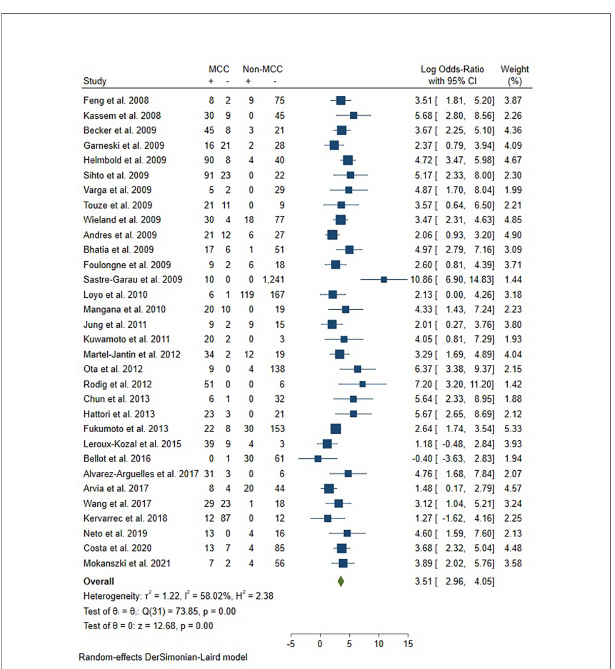
FIGURE 2 | Forest plot illustrating the odd ratio for the association between MCPyV and MCC.